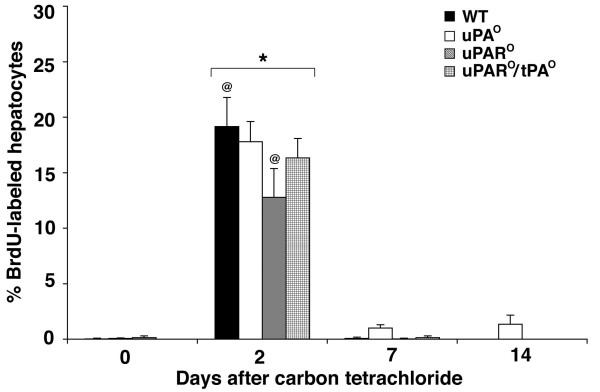
Transient decrease in proliferation of hepatocytes in mice lacking uPAR. Quantification of BrdU-labeled hepatocytes shows a rise in BrdU uptake in all experimental groups 2 days after CCl4, with a decrease of ~33% in uPAR° livers. The percent of BrdU-labeled hepatocytes return to near baseline levels in all groups. WT = wild type. (*ANOVA P < 0.004; @t-test P < 0.004; N = 3–8 at each time point).